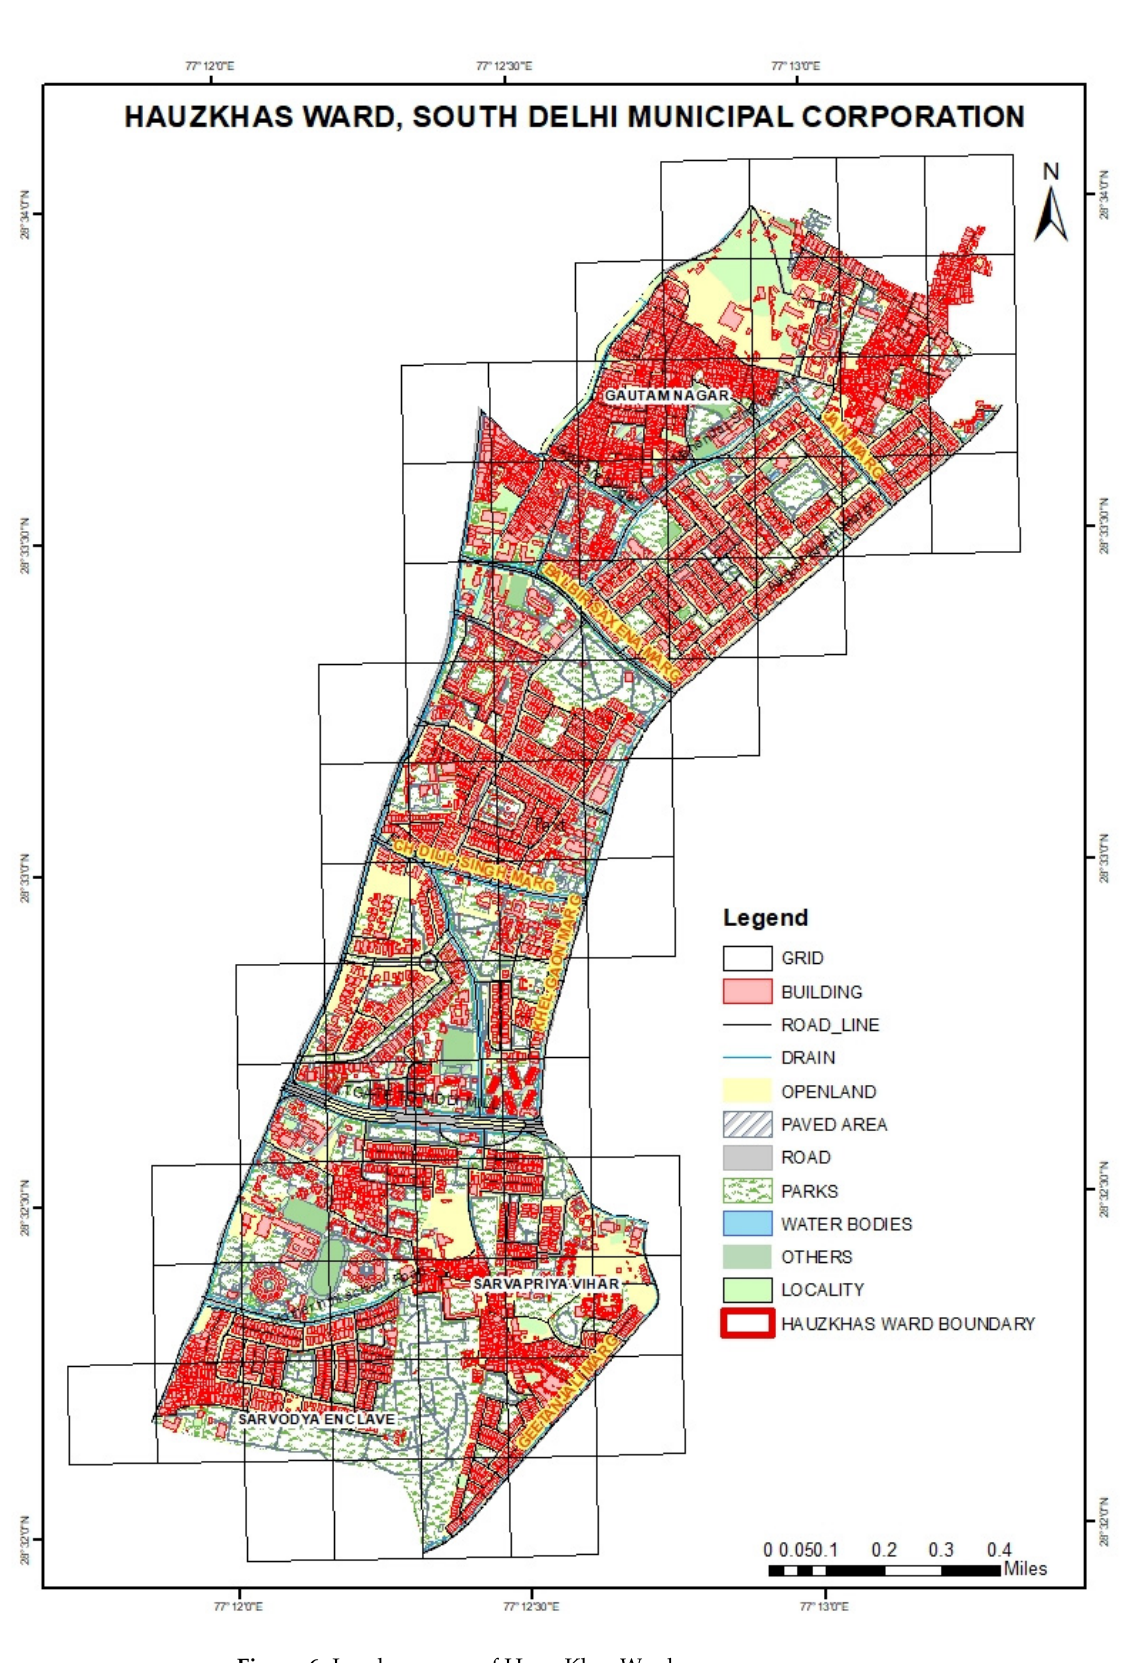
Figure 6. Land use map of Hauz Khas Ward.